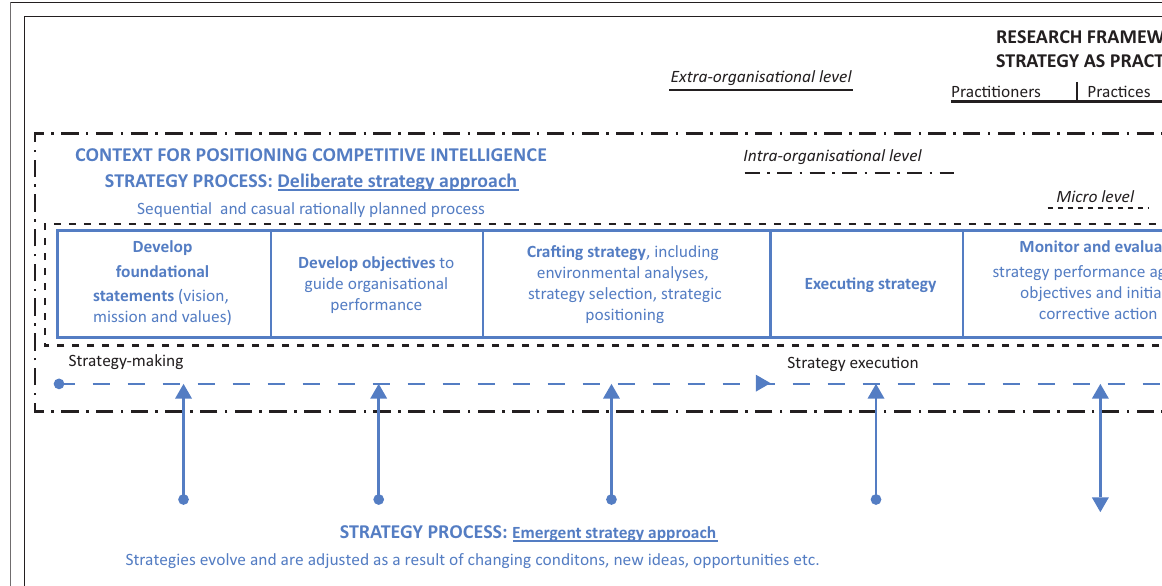
FIGURE 1: Key linkages between strategy process, strategy as practice and competitive